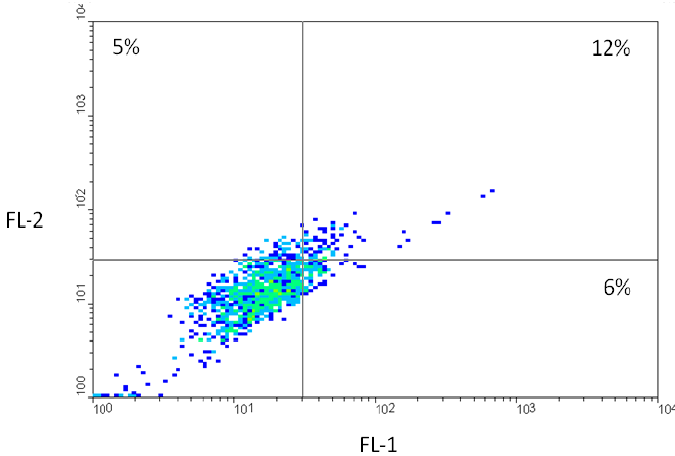
Figure 8. Fluorescence-activated cell sorting analysis after co-icubation of HCT116 cells with FITC-labeled CaIX-P1 and rhodamine-labeled anti-human CAIX mAb. Low left box : unlabeled cells (autofluorescence). Low right box : cells labeled only with FITC-CaIX-P1. Upper left box : cells labeled only with rhodamine-anti-CAIX-mAb. Upper right box : Cells labeled with both FITC-CaIX-P1 and